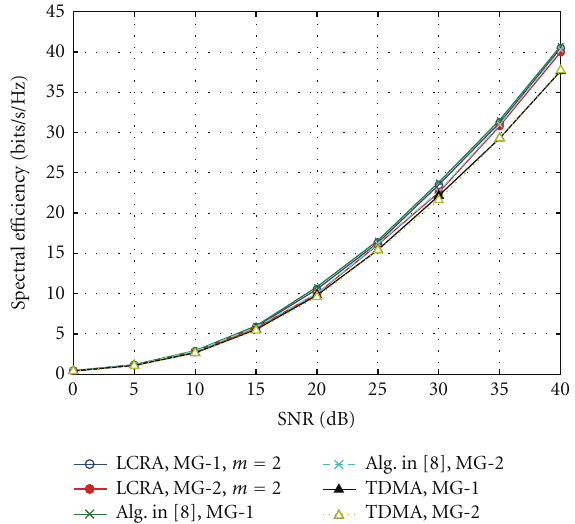
Figure 13: Individual MG spectral e ffi ciency versus SNR—no pathloss di ff erence between MGs.